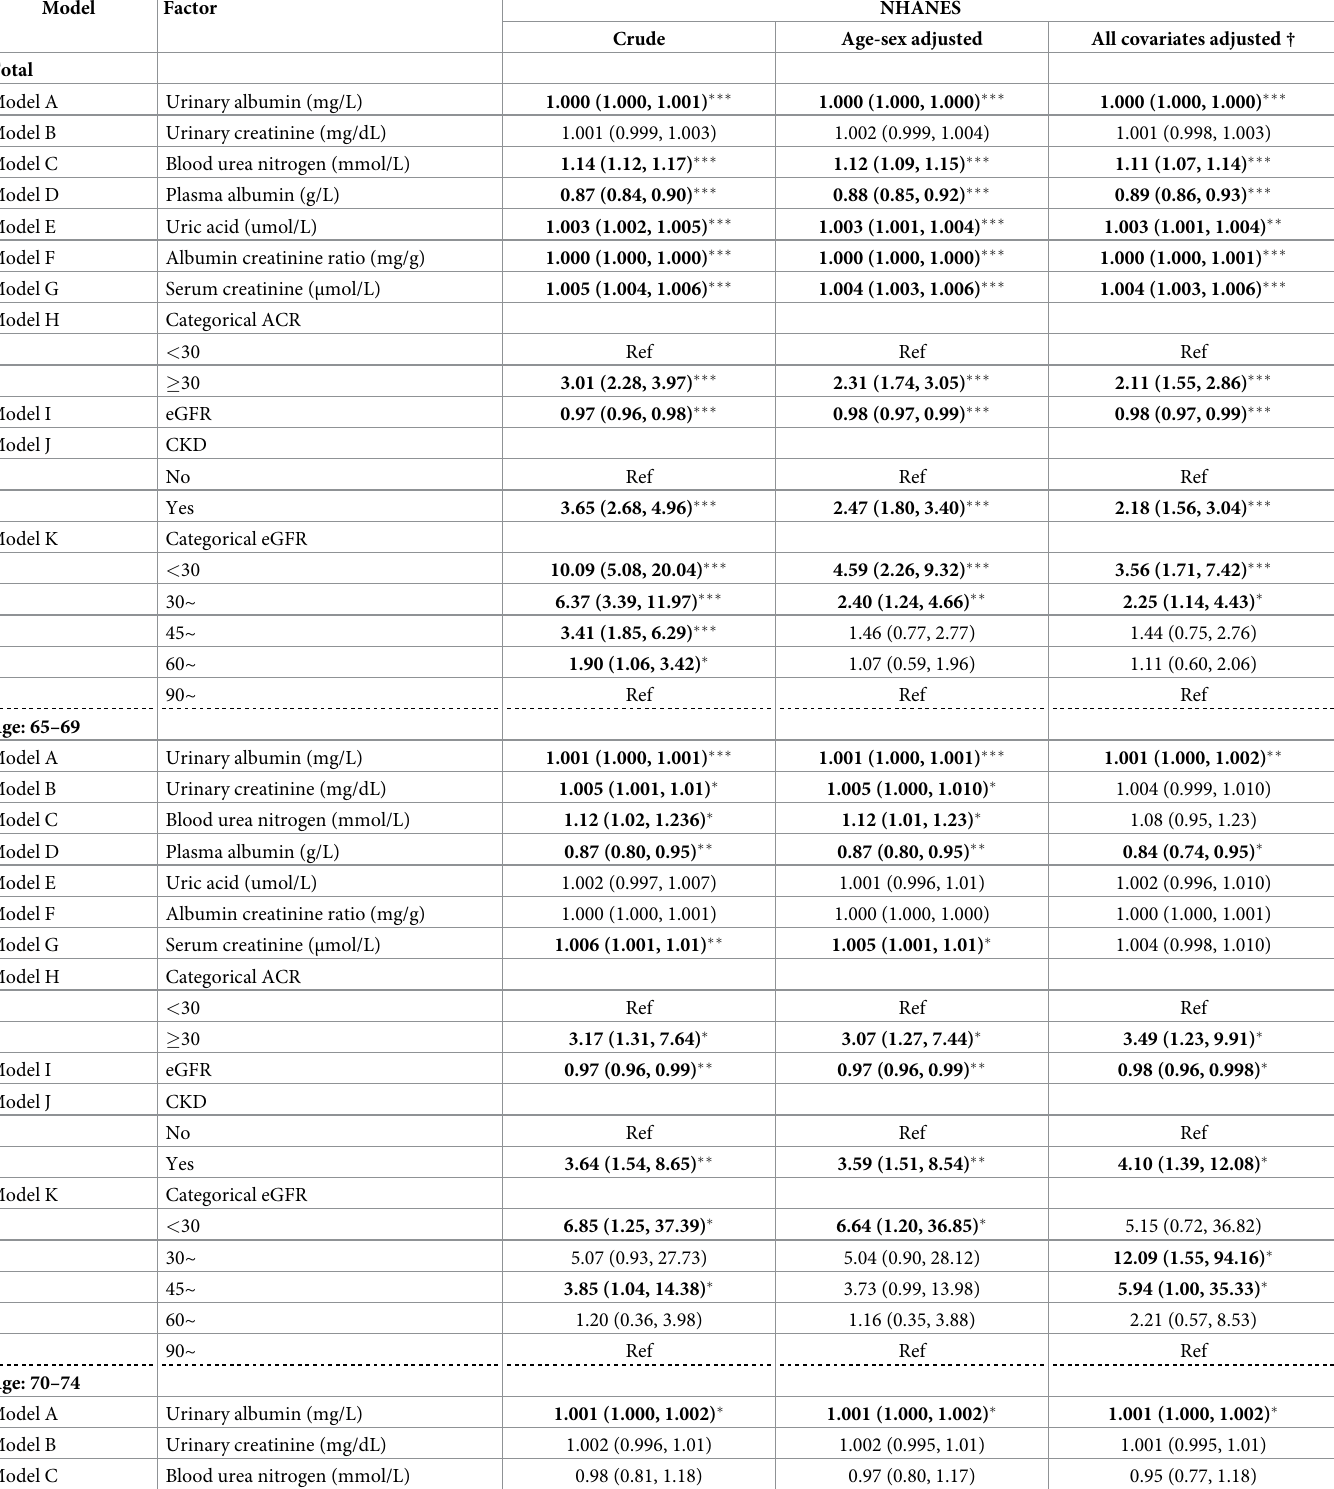
Table 6. Hazard ratio (95% CI) of biomarkers on mortality in US participants (NHANES 2011–2014).